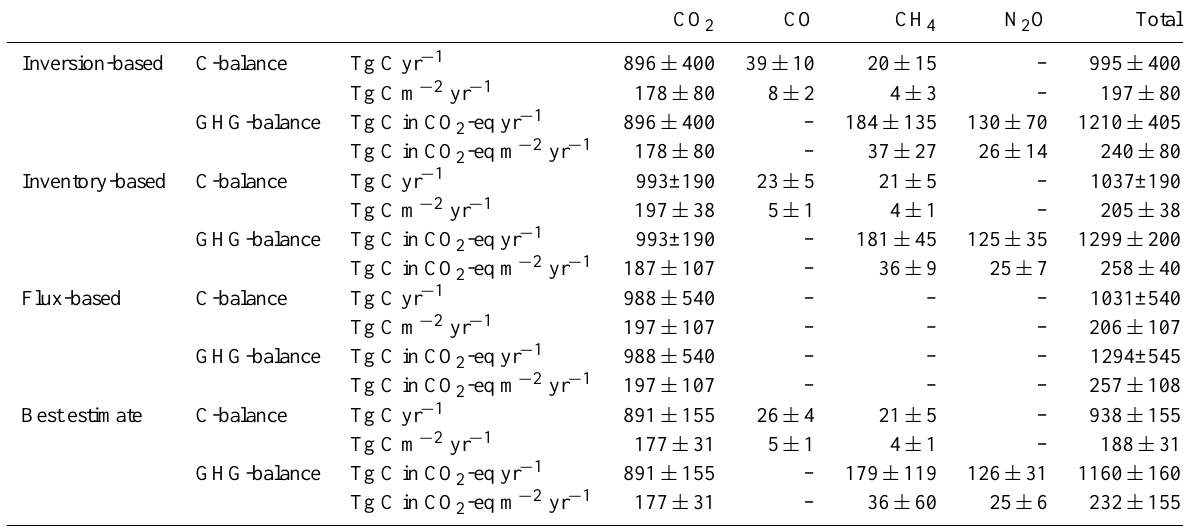
Table 2. Carbon (TgCyr − 1 ) and GHG (Tg C in CO 2 -eq yr − 1 ) balance for CO 2 , CO, CH 4 and N 2 O between 2001 and 2005 estimated from inversions (Eq. 1), inventories (Eq. 7) and flux-based approaches (Eq. 2; only for CO 2 ) . Fluxes per unit area were calculated for a European surface area of 5035147km 2